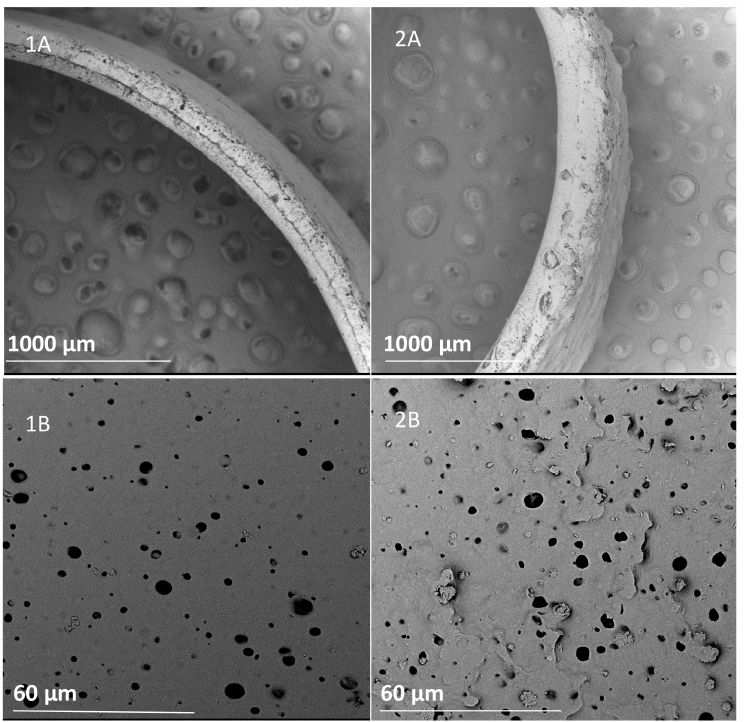
Figure 10. Comparison of representative SEM images of cross-sections ( A ) and sample surface ( B ), PU C45D ( 1 ), and PU C45D_10% PVA ( 2